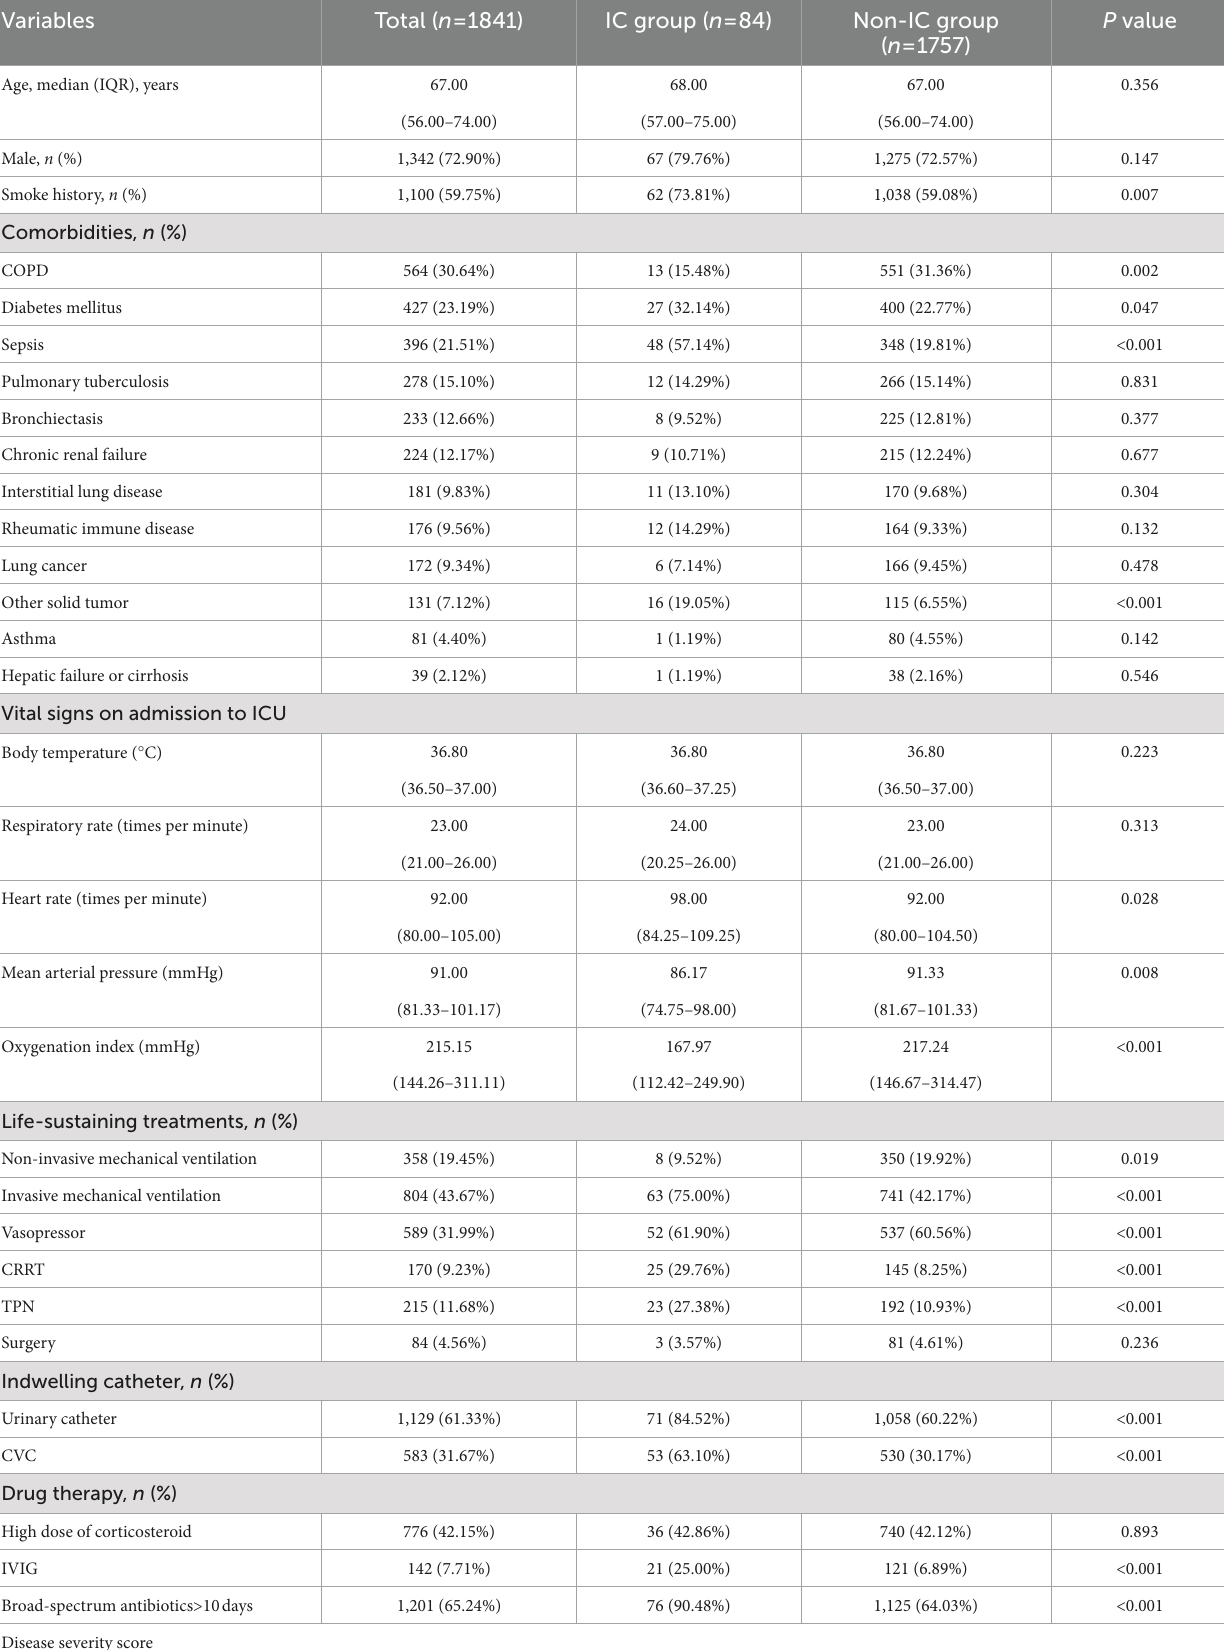
TABLE 1 Baseline characteristics in immunocompetent critically ill